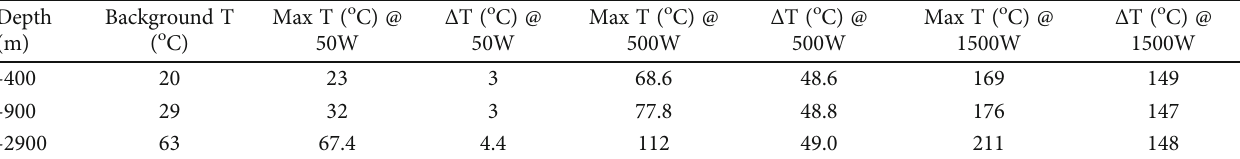
Table 4: Highest recorded absolute temperature and temperature increase at R = 1m for di ff erent heat outputs.